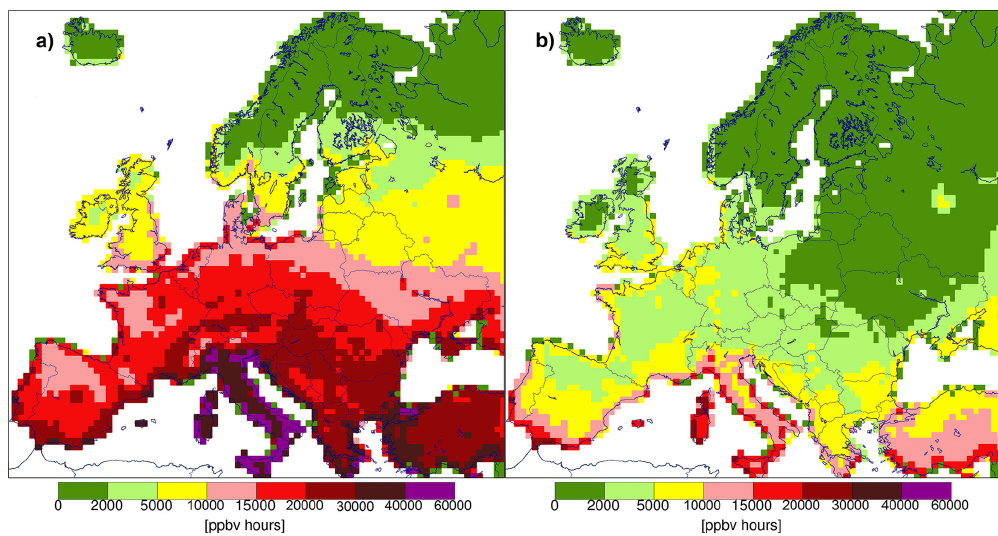
Figure 5. Present and future modelled AOT40 (ppb-hours) as 20-year averages (a) 1990–2009 and (b) 2040–2059 assuming O 3 precursor emission reductions according to the RCP4.5 scenario and climate change under the IPCC SRES A1B scenario. AOT40 was accumulated over daylight hours (global radiation >50Wm − 2 ) during the O 3 sensitive period relevant for coniferous and evergreen tree species. Model results are based on O 3 concentrations from the lowest model layer ( ∼ 30m above